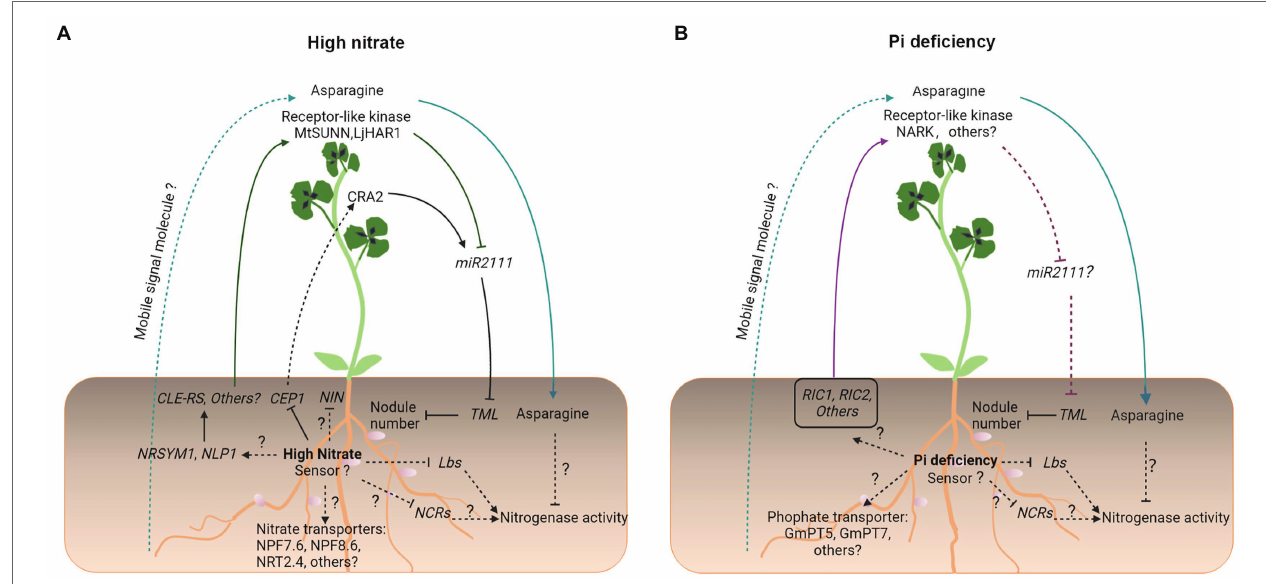
FIGURE 3 | An overview of symbiotic signaling under high NO 3 − and Pi deficiency in legumes. Under conditions of (A) high NO 3 − and (B) Pi deficiency, compromised legume–rhizobial symbiotic interactions share both similar signaling processes and unique processes. Similar symbiotic signaling processes include enhanced CLE-like/LRR-RLK-dependent AON signaling, a significant increase in the production and transport of the N-compound asparagine from the shoot to root nodules, where it inhibits nitrogenase activity, and reduced the expression of genes encoding Lbs and NCR peptides, which are essential to maintain the nitrogenase activity. Unique symbiotic signaling processes include transport, initial signal perception, and transduction. Solid and dashed lines indicate the processes that are supported by experimental evidence and putative, respectively. Question marks indicate unknown